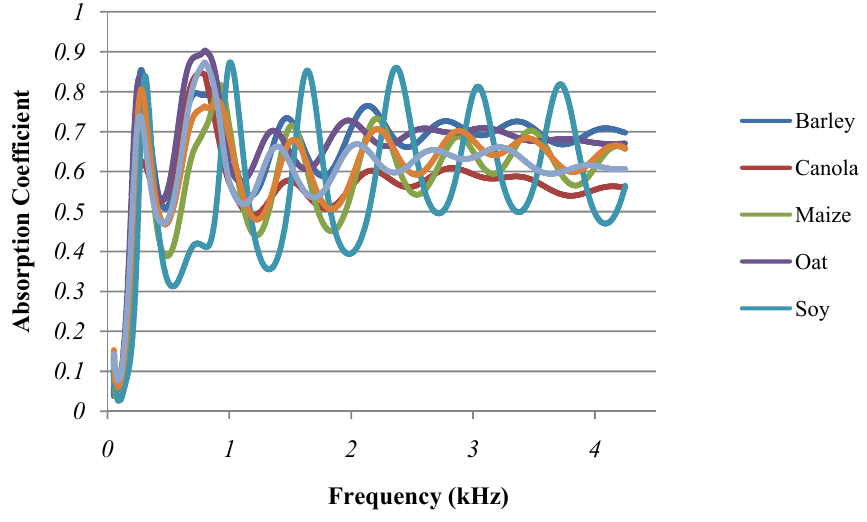
Figure 3. Absorption coefficient spectra of the wheat